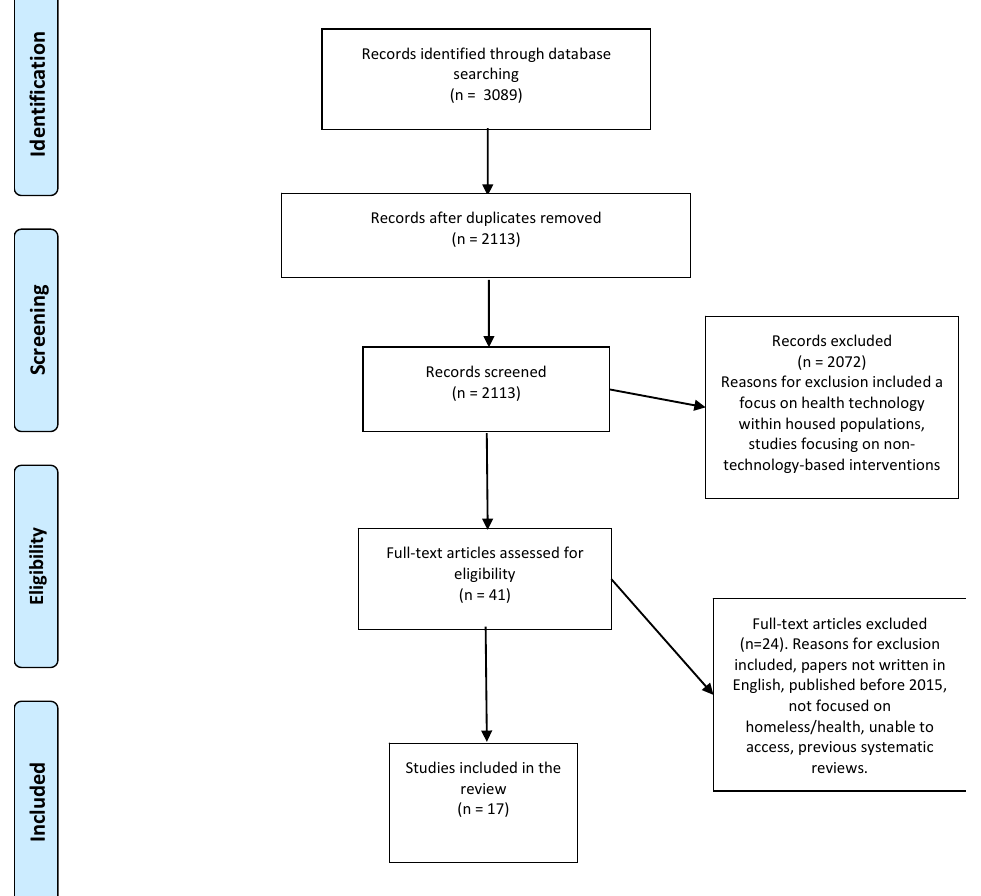
Figure 1. PRISMA Flow Chart [41].